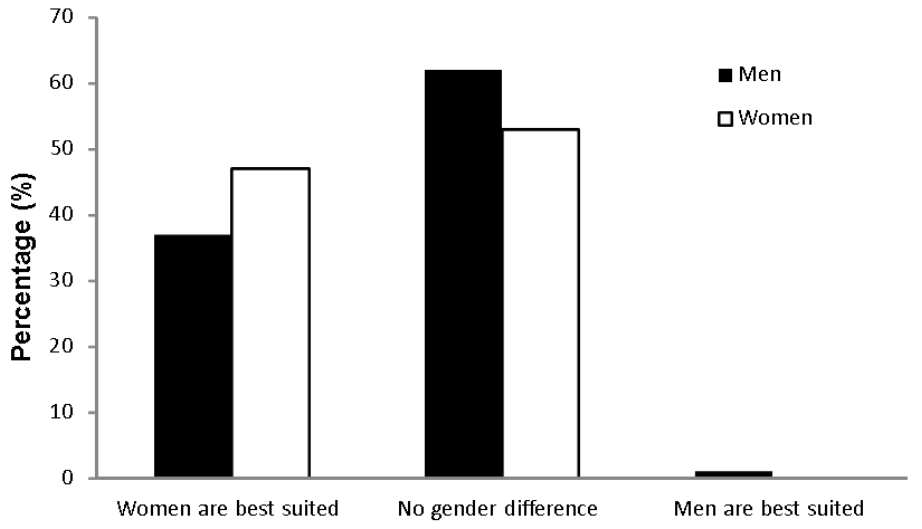
Figur 2. Assumptions about verbal skills for men (N = 183) and women (N=